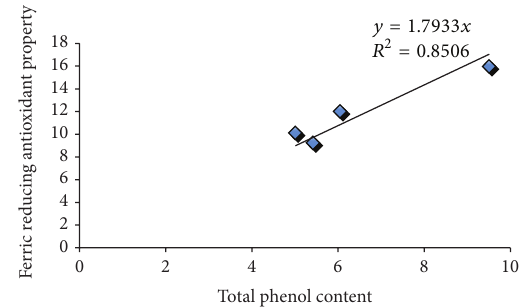
Figure 6: Relationship between the total phenol content and ferric reducing antioxidant properties of some commonly commercially available